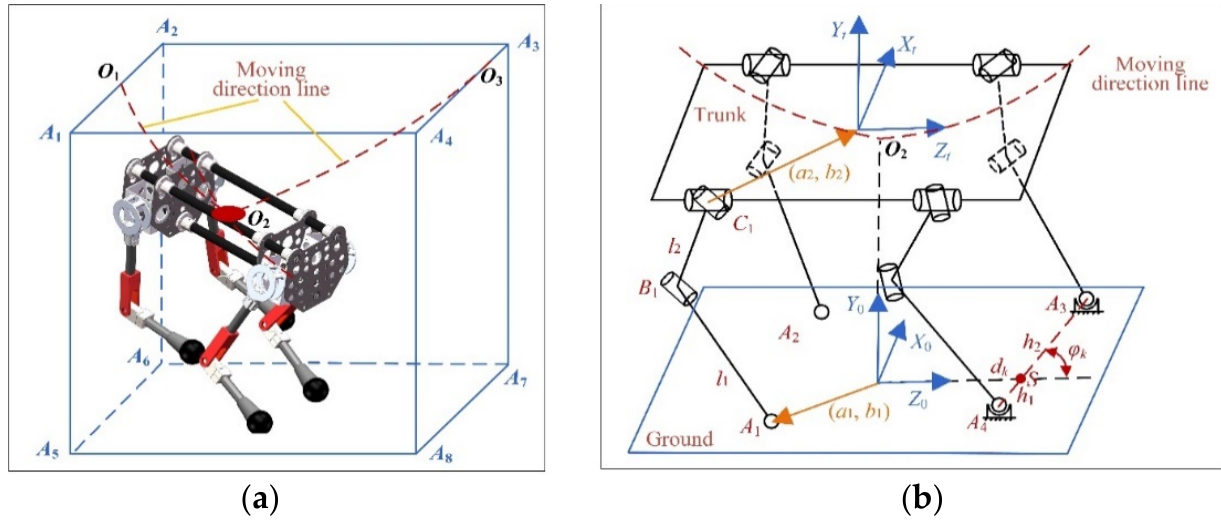
Figure 2. ( a ) Trajectory of the trunk of the cheetah-inspired quadruped robot in the process of changing the motion direction in the leg landing phase. The trajectory O 1 O 2 of the center of mass of the trunk in the descending phase and the trajectory O 2 O 3 in the ascending phase are not coplanar. ( b ) Mechanism diagram of the cheetah-inspired quadruped robot. First, the motion law of the trunk must be determined. Trajectories O 1 O 2 and O 2 O 3 can be expressed as S t ( x , y , z ) = S